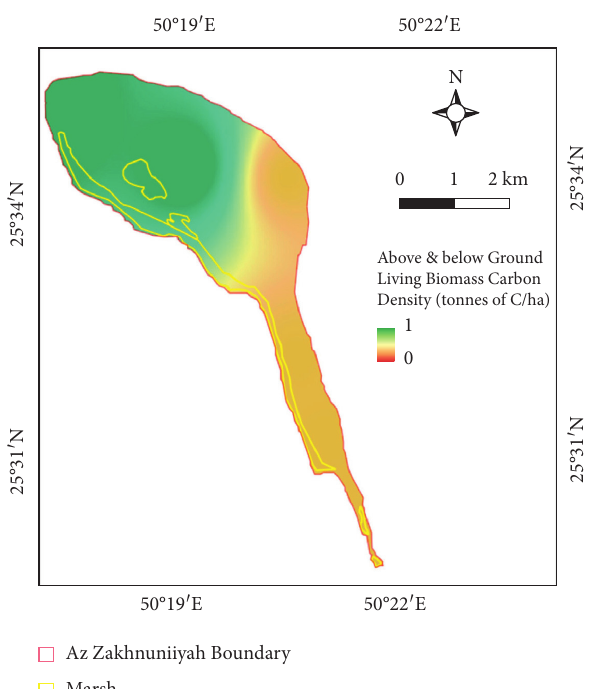
Figure 4: Above and below ground living biomass carbon density map. Units in tonnes of carbon/hectare.